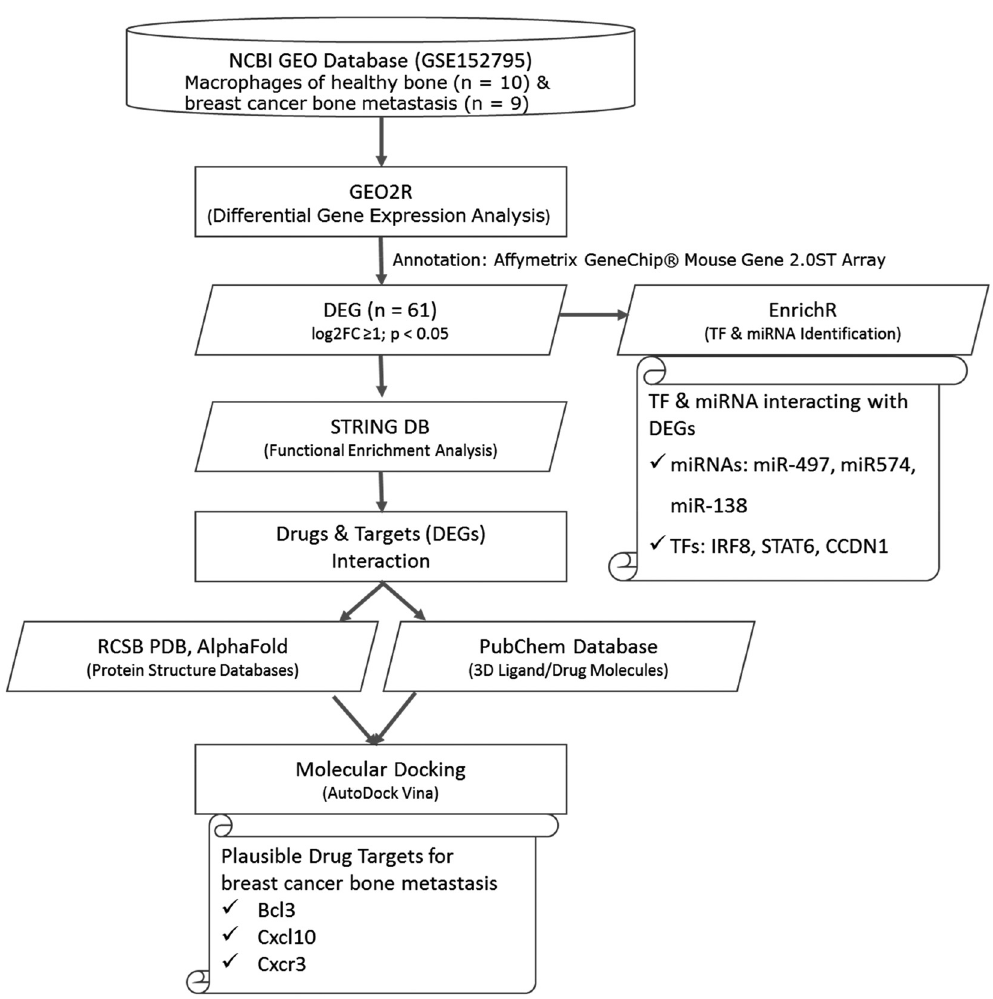
Figure 1: The overall workflow of the methods employed in identifying drug targets, TFs and